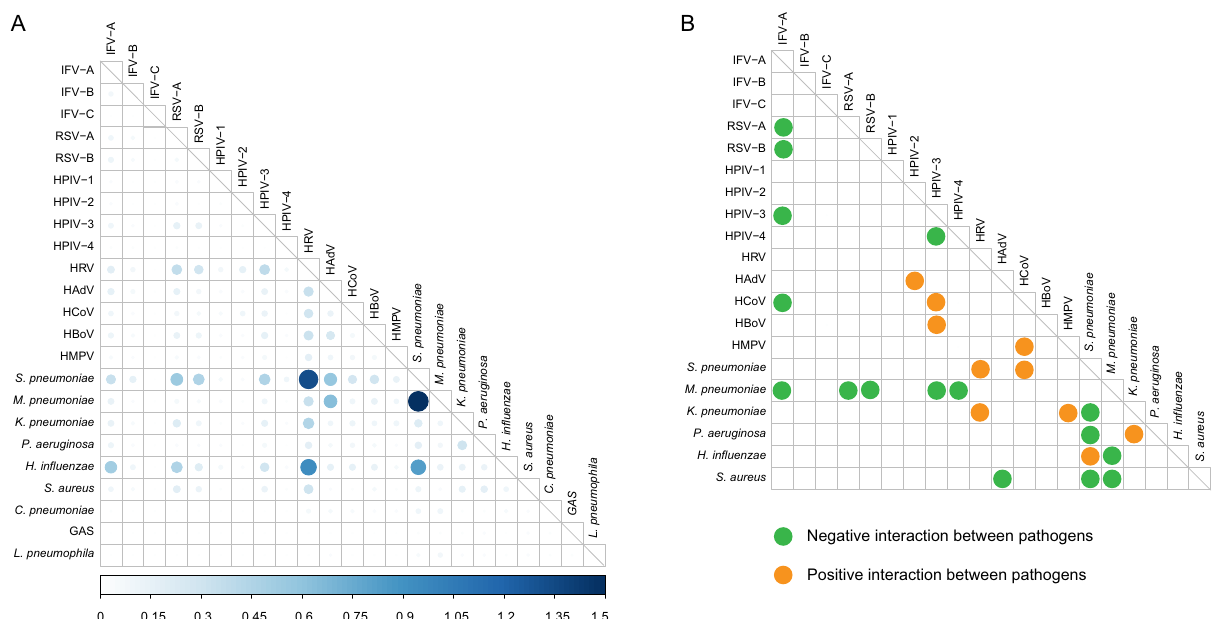
Fig. 3 Coinfection pattern and interactions of pathogens in patients with acute respiratory infection in the mainland of China, 2009 − 2019. A Coinfection rates were calculated pairwise. For pathogen ‘ X ’ and ‘ Y ’ , numerator was the number of patients coinfected both ‘ X ’ and ‘ Y ’ and the denominator where the total number of patients who were both tested ‘ X ’ and ‘ Y ’ . Bigger size and darker color of the circles indicate higher coinfection rates between two pathogens. B The interactions among pathogens are estimated by host-scale logistic regressions. Positive interactions with two-sided p value <0.05 were denoted in orange and the negative interactions with two-sided p value <0.05 were denoted in green color. The p values were not adjusted for multiple comparisons. The interaction was determined as both signi fi cant when without adjusting for multi-pathogens (Supplementary Table 3) and when adjusting for multi-pathogens (Supplementary Table 4) L. pneumophila, C. pneumoniae, and GAS were not included in the logistic analysis due to the small sample